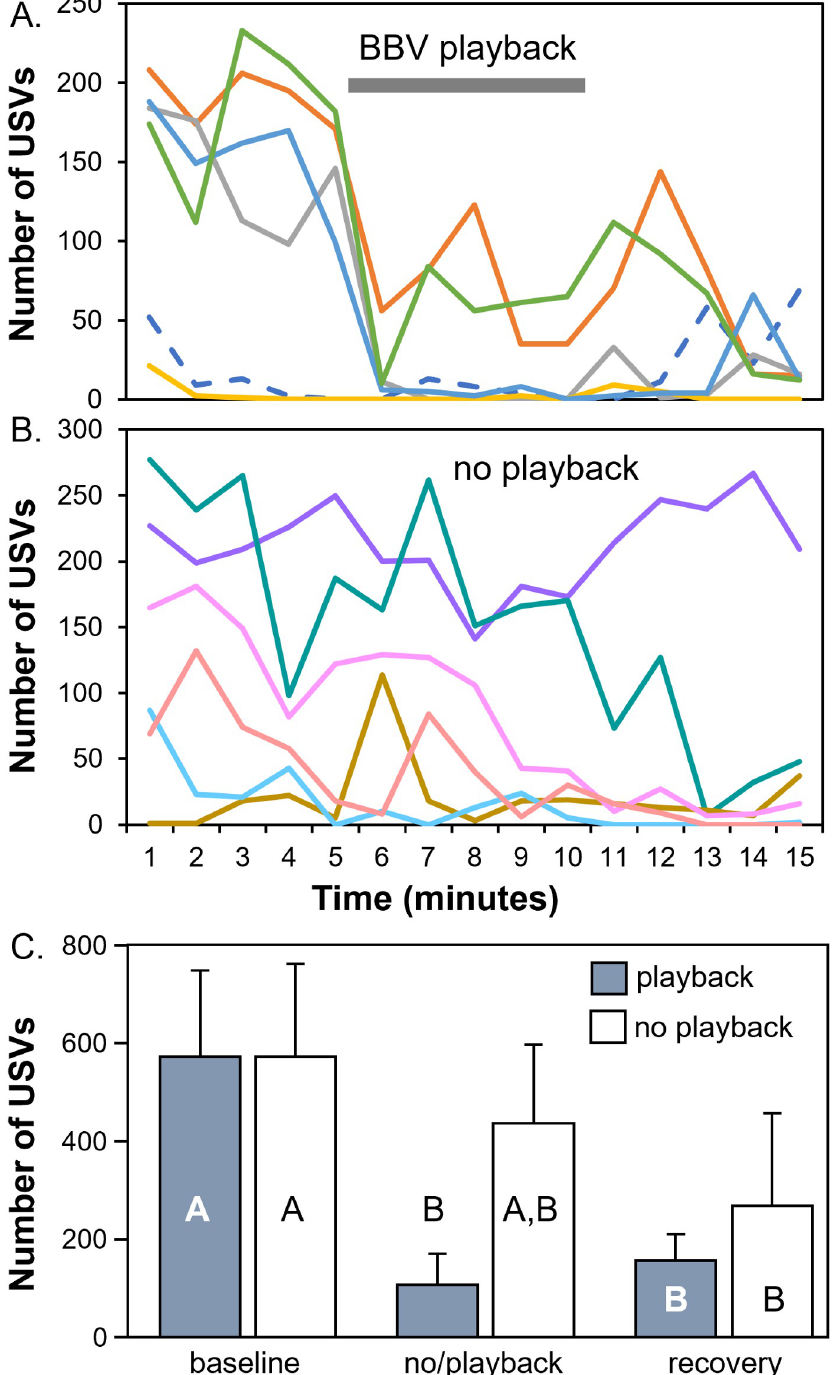
Fig 7. Comparison of numbers of USVs produced with A) BBV playback (n = 6) and B) no playback (n = 6) in males presented with soiled female bedding only (dashed line), or paired with anesthetized females (solid lines). (A) and (B) show 1-minute bins, with the gray bar in (A) marking the duration of playback. The onset of playback was associated with a sharp decrease in the numbers of USVs in interactions with robust USVs in the first five minutes. Interactions in (B) also appear in Fig 2. Colors represent different individual trials: different males were used for trials in (A) and (B). C) Average USV numbers for the three five-minute time bins for the trials represented in A) and B), with gray = playback and white = no playback trials. For playback trials, a significant decrease occured in the playback relative to the baseline time period, something that did not occur for no-playback trials. Letters represent Fisher’s least significant difference posthoc tests for a repeated measures ANOVA, as described in the text. Columns with different letters are significantly different from each